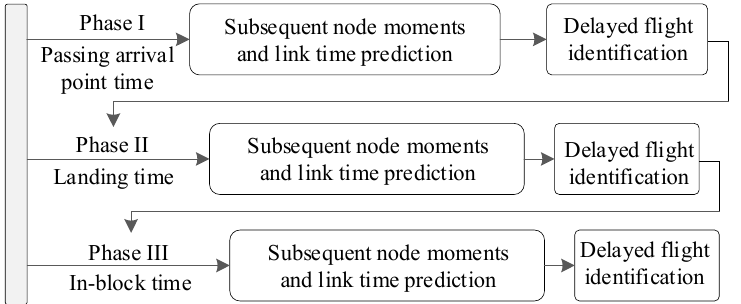
Figure 2. Flight delay prediction process.